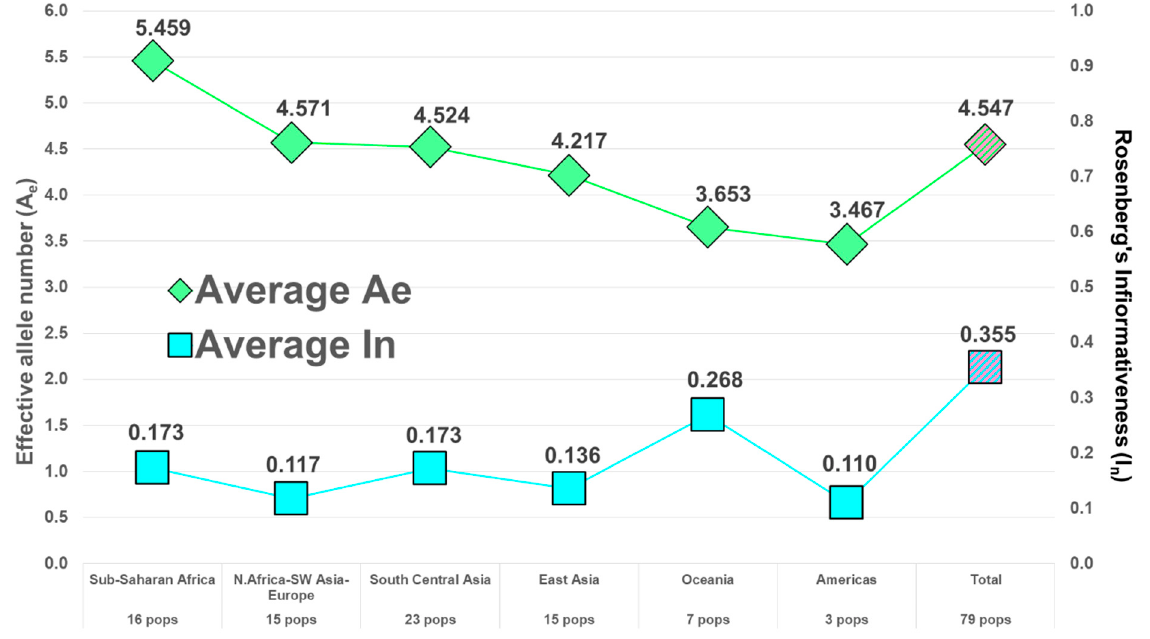
Figure 4. Average A e and average I n in 6 major world regions for 90 microhaplotypes.